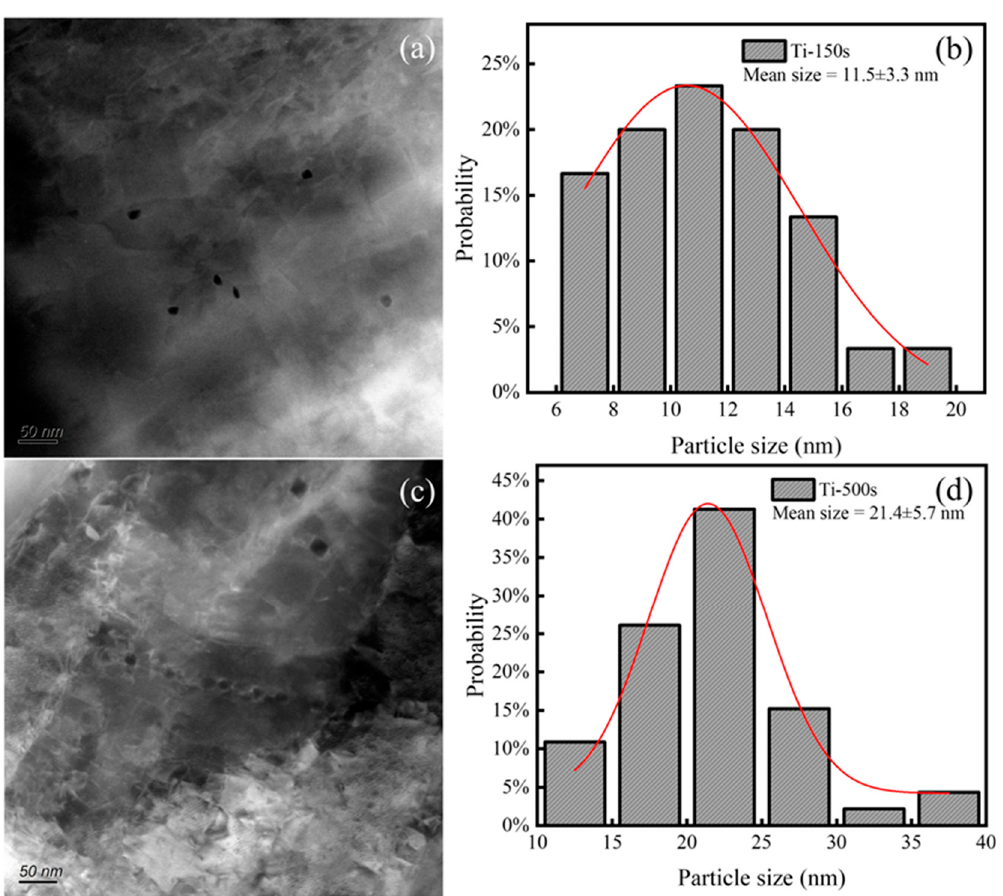
Figure 6. Carbide evolution and particle size distribution in Ti microalloyed steel deformed at 900 °C and held for ( a , b ) 150 s; ( c , d ) 500 s.